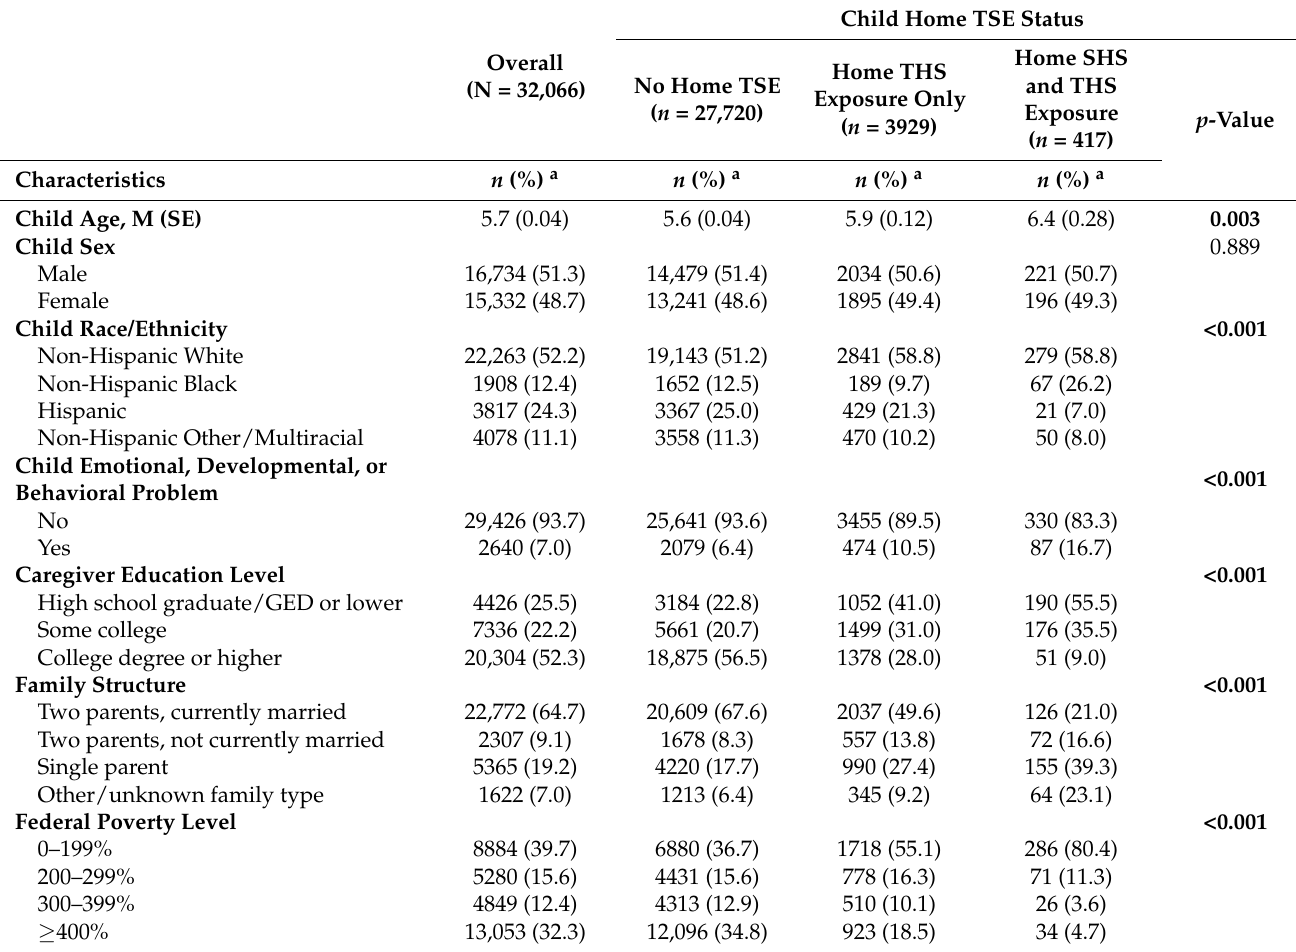
Table 1. Covariates Overall and Based on Child Home TSE Status among U.S. Children